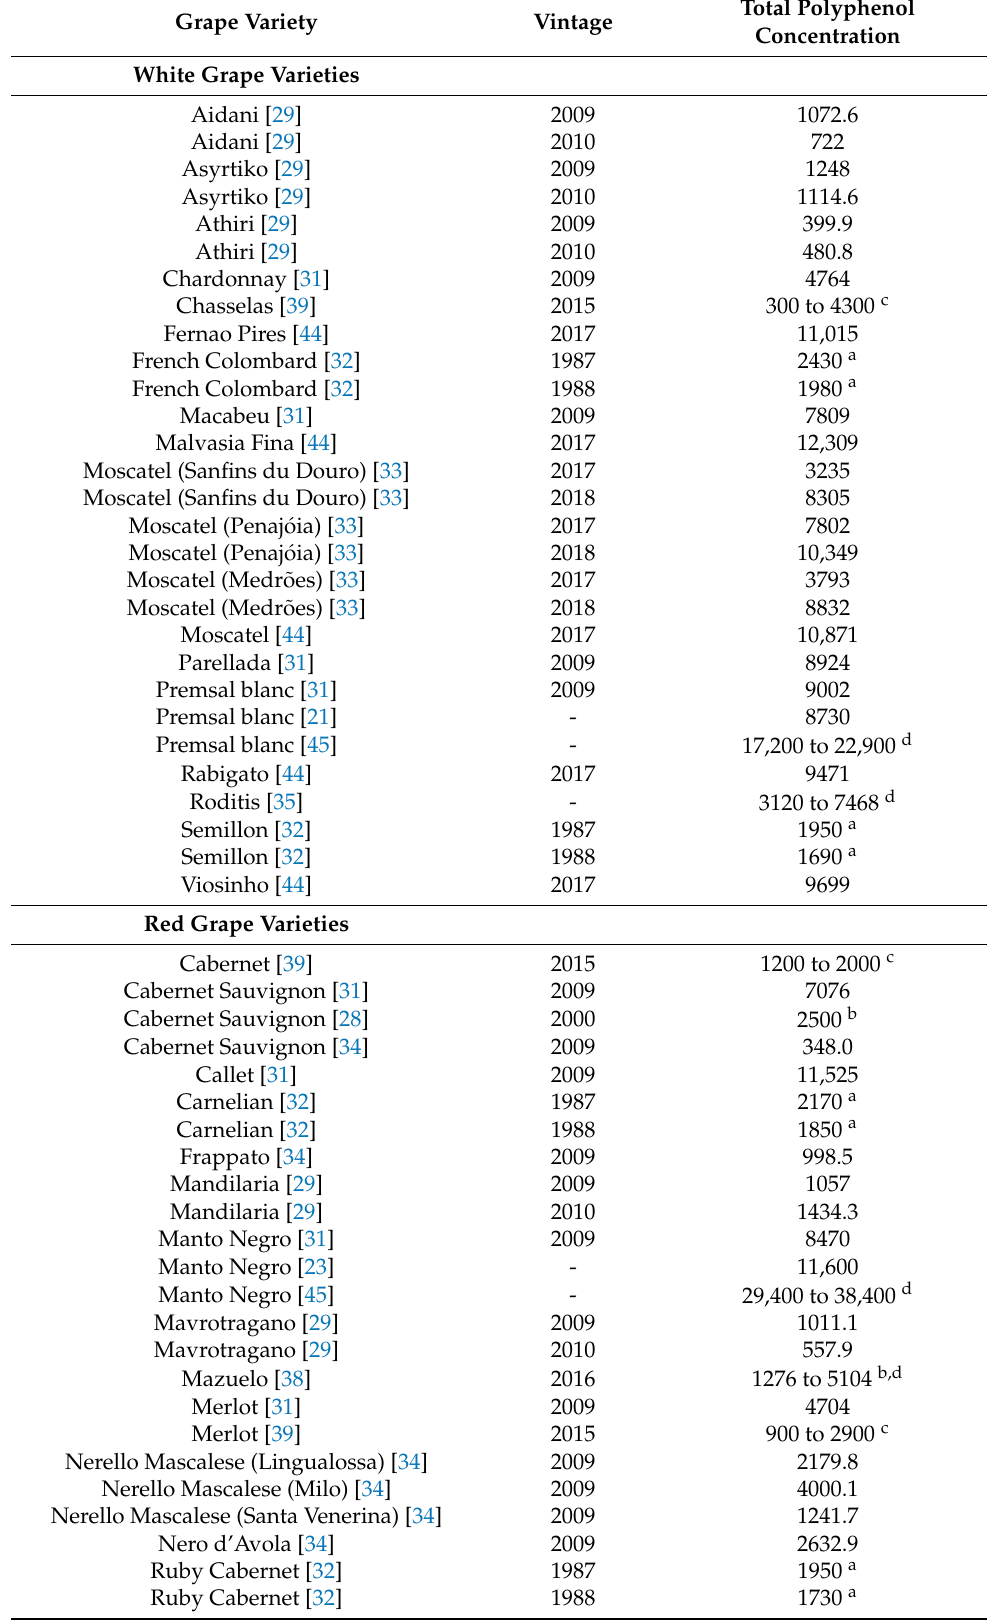
Table 2. Total polyphenol content of stems of white and red grape varieties (mg GAE/100g